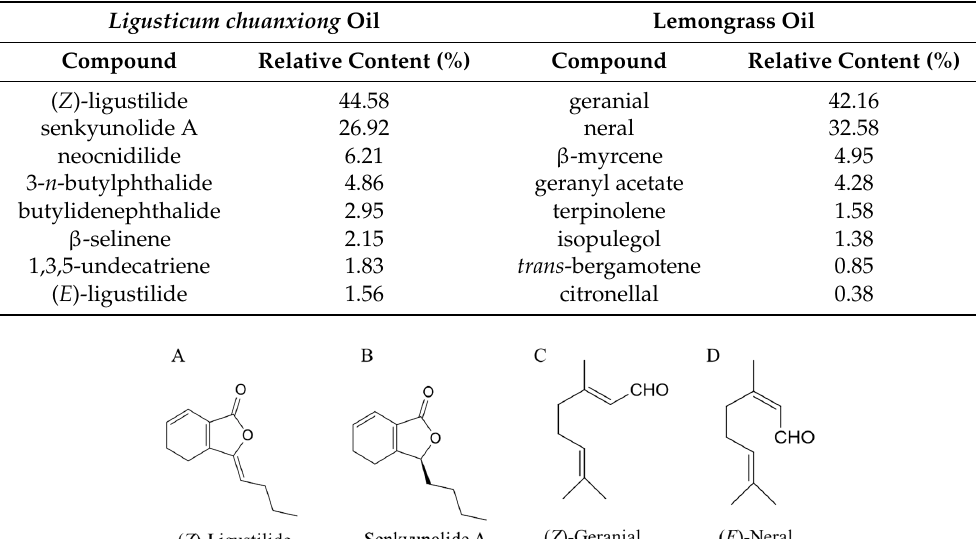
Table 2. Identification and quantification of principal compounds from Ligusticum Chuanxiong oil and lemongrass oil in gas chromatography–mass spectrometry (GC-MS).